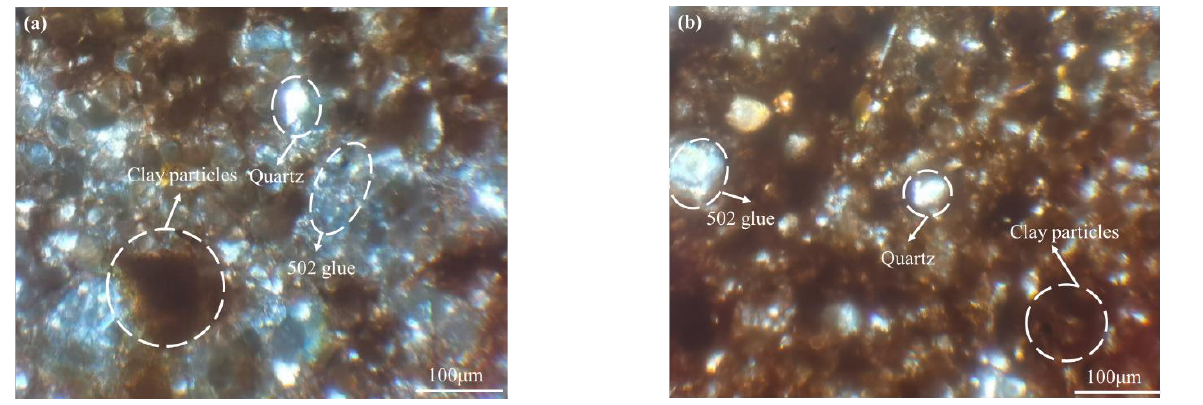
Figure 12. Polarization microscopy analysis diagrams (orthogonal polarization): ( a ) CCC and ( b ) clinoptilolite/Na PAA modified CCC.